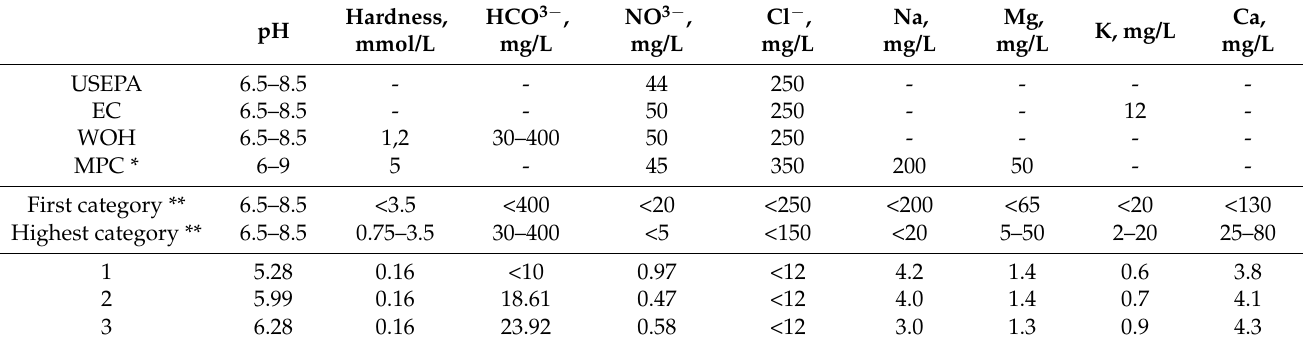
Table 3. Content of macro components, anions, pH, and total hardness in spring